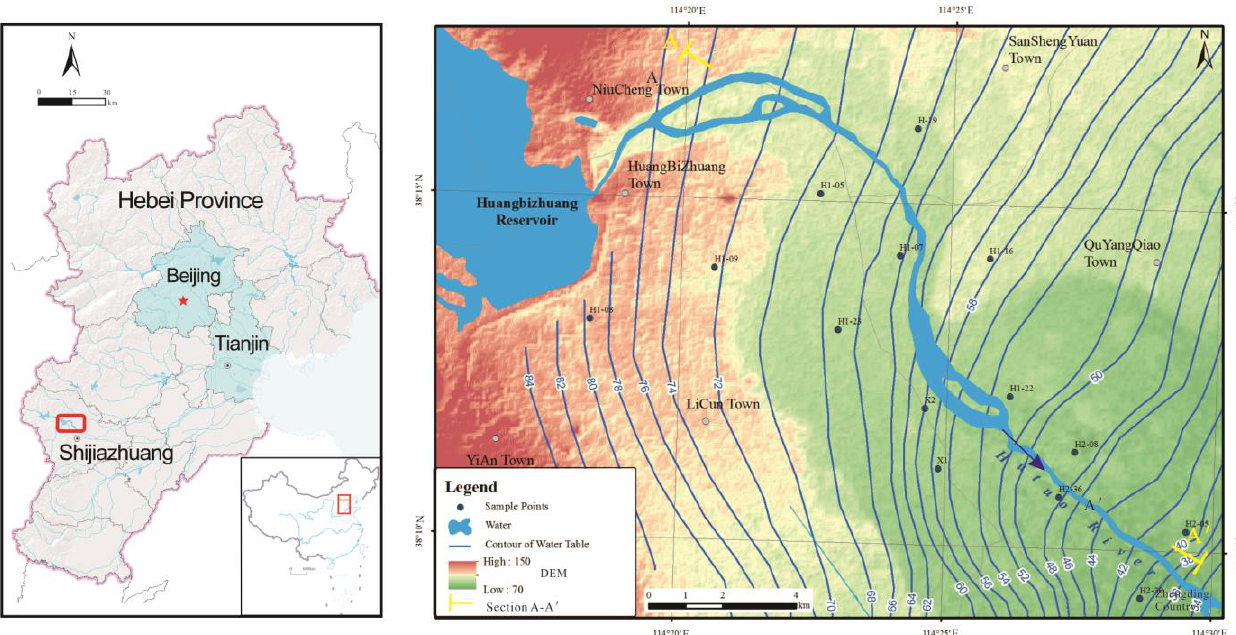
Figure 1. Scope of the study area.